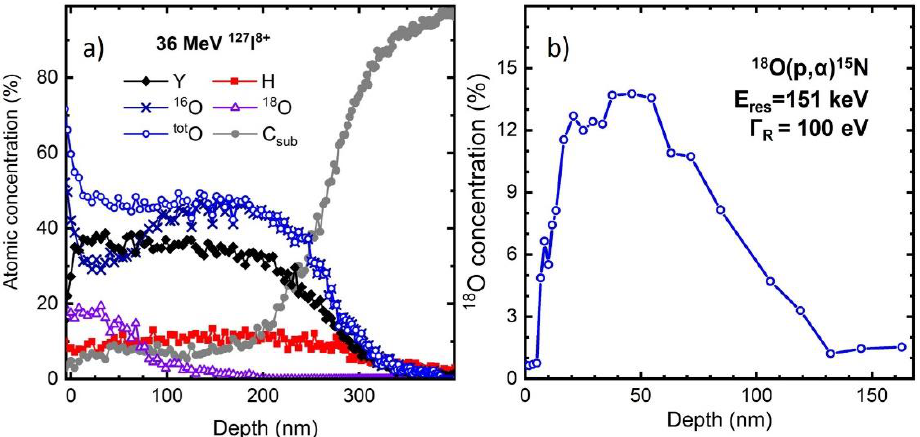
Fig. 3. Depth profile of chemical elements for the fully oxidized bilayer YHO film derived from ToF-E ERDA (a). Depth distribution of 18 O in the YHO film calculated from NRA measurements